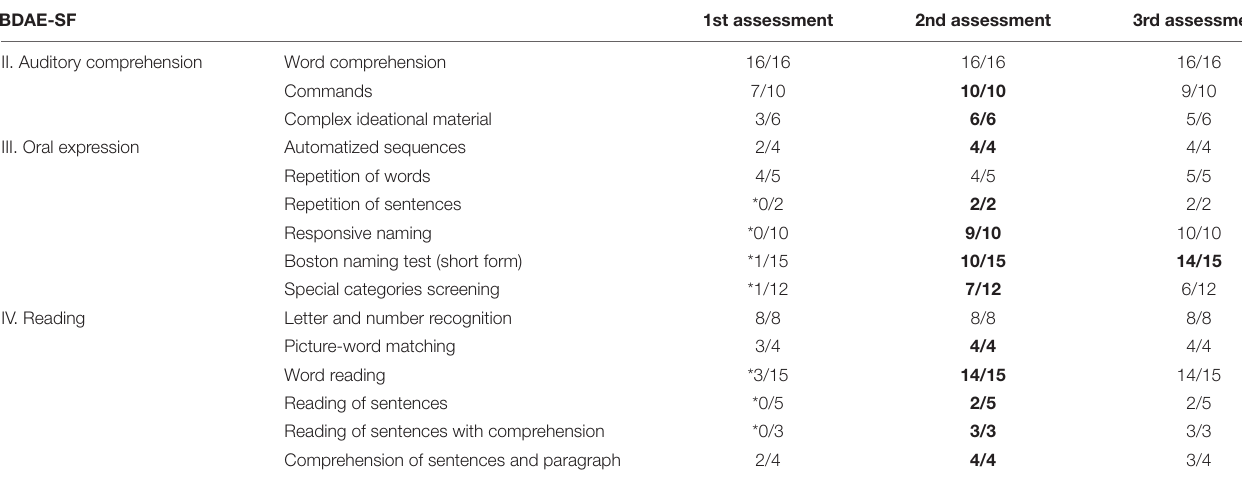
TABLE 2 | Th.G.’s performance on each subsection of the three sections of BDAE-SF before (1st assessment), just after MIT (2nd assessment), and 3 months after the completion of MIT (3rd assessment) (* indicate significantly low performance, bolded numbers indicate significant progress).